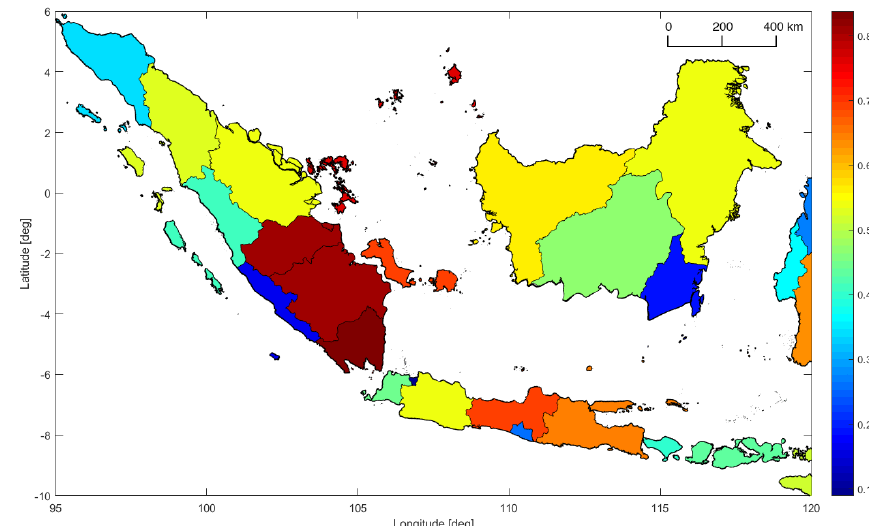
Figure 7. Coefficient of variation (CV) of the loss rate inside provinces in western Indonesia. Color denotes the CV.